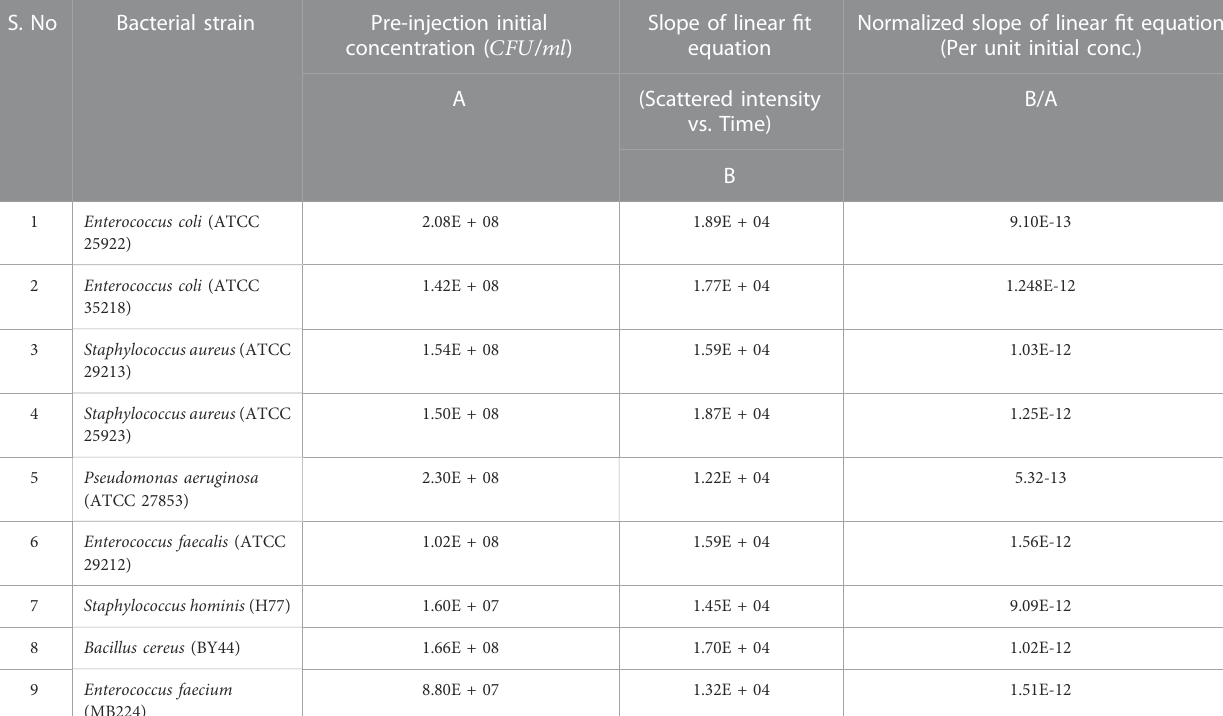
Figure 4. The multiplication factor of 10 – 8 in the normalized intensity values is not shown on the vertical axes to avoid clutter in the plot. Again, the fi rst values of the 1- s averaged data were deducted from all the consecutive values of x, y, and the normalized scattered intensity, for each trial while plotting Figure 4, with 1,200 averaged backscattered data points for each subplot to ensure statistical robustness and the elimination of 1) the